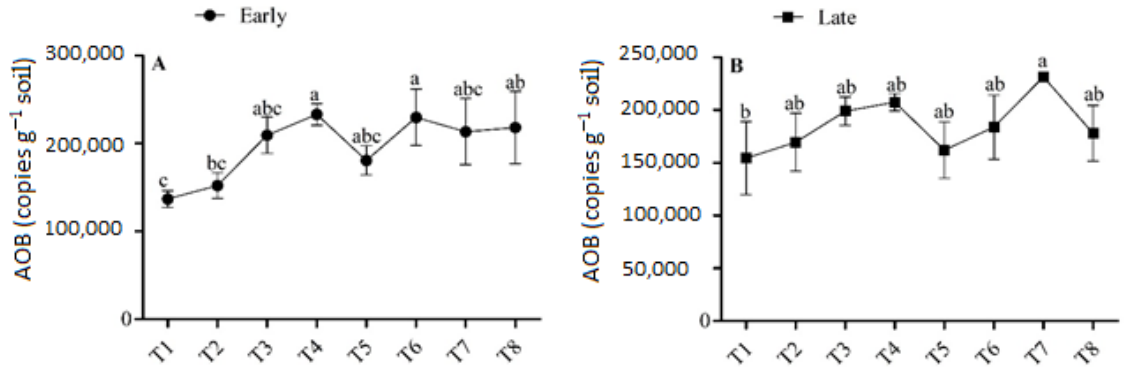
Figure 4. ( A , B ) Concentration of AOB in the early and late season under high ‐ and low ‐ dose urea application and different levels of biochar application. Note: Bars with different letters are signifi ‐ cantly different, at p < 0.05. significantly different, at p <